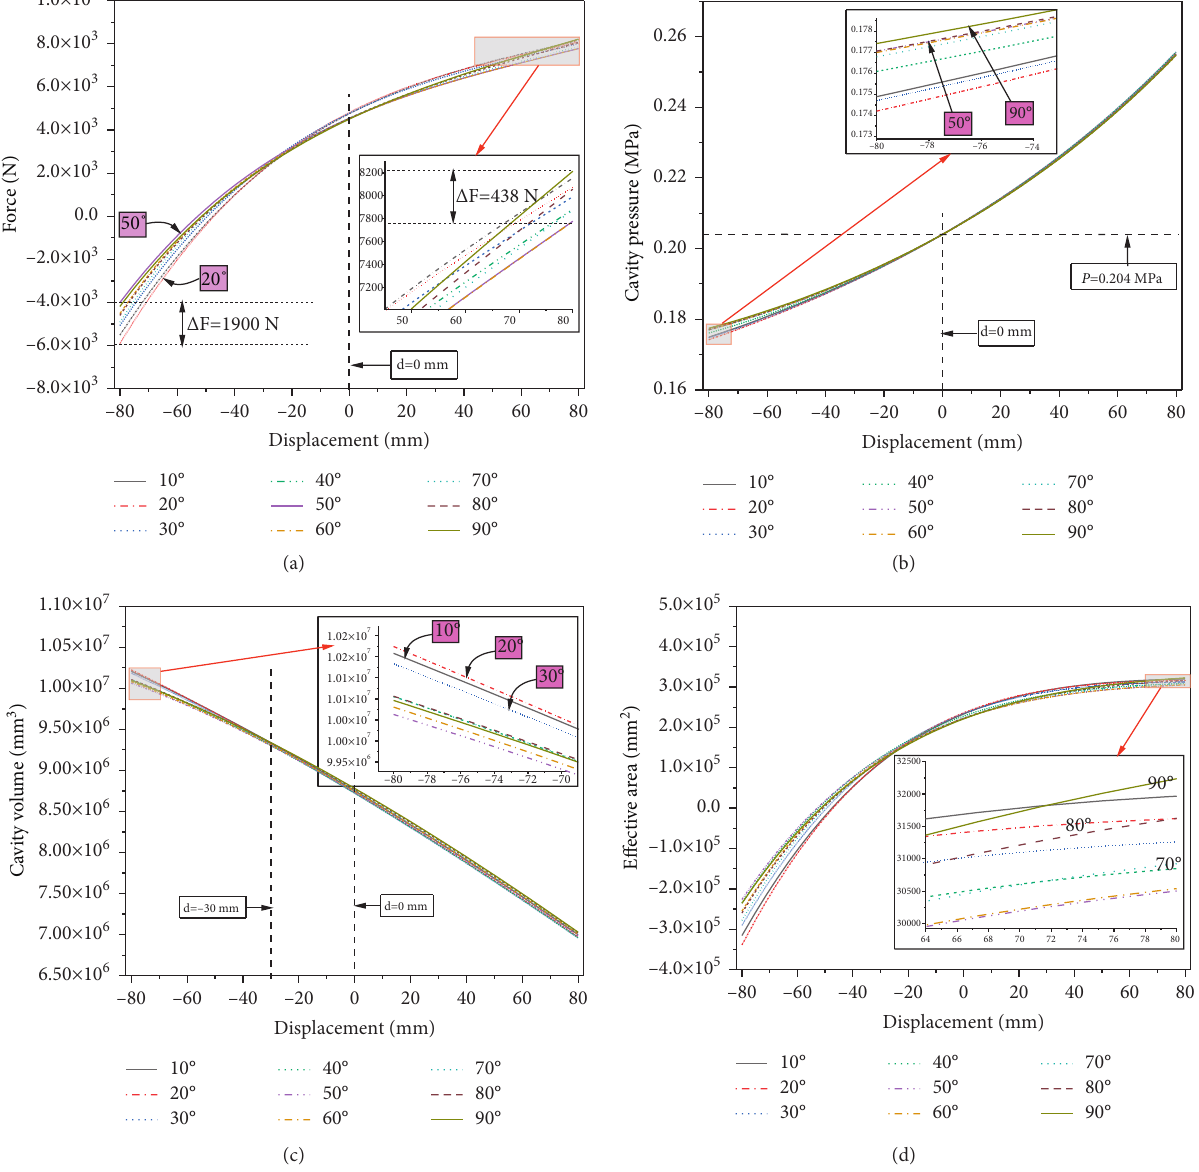
Figure 13: Effect of cord angle on airbag: (a) for load, (b) for pressure, (c) for volume, and (d)for effective